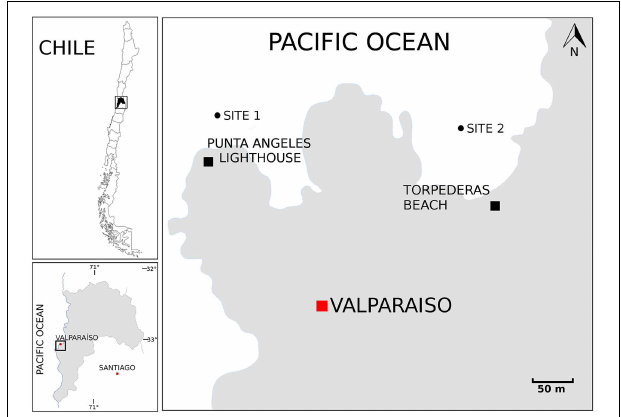
FIGURE 1 | Map showing the sampling locations. Map of Chile. Boxed region is enlarged in the left bottom panel to emphasize the Valparaíso Region and boxed region is enlarged in the right panel to emphasize the sampling sites located near Punta Ángeles Lighthouse and Torpederas Beach.